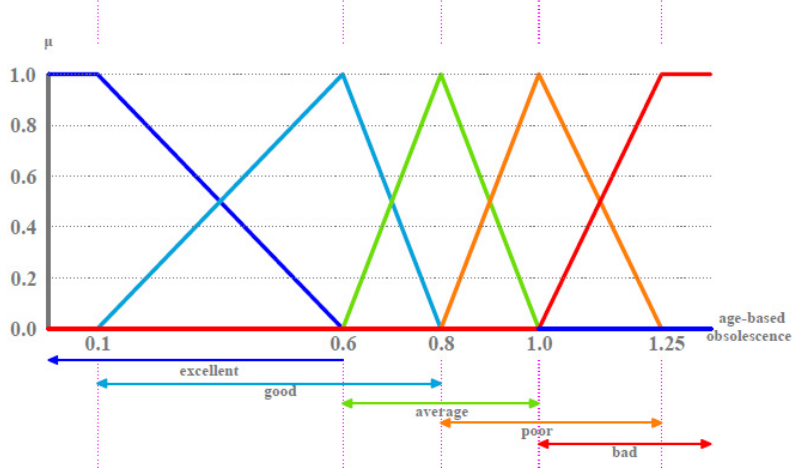
Figure 8. Membership functions of the condition scale for Age-based obsolescence.